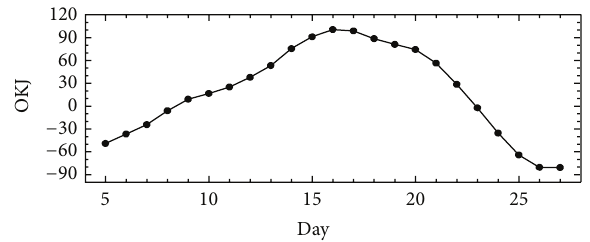
Figure 3: Daily OKJ index (nine-day running mean) evolution on July 5–27,